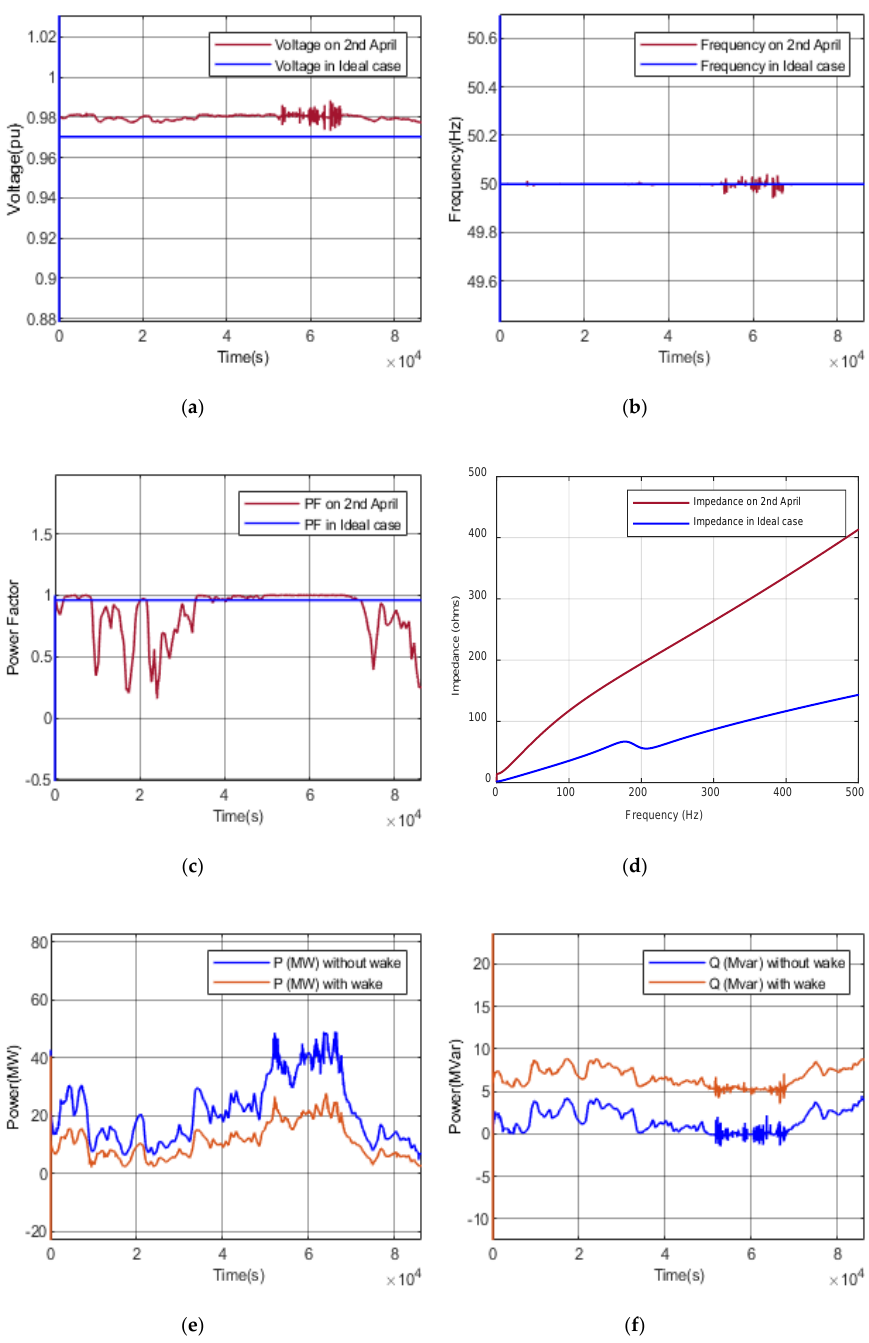
Figure 6. Case-1, Scenario 3: ( a ) Voltage (V) at PCC; ( b ) frequency (F) at PCC; ( c ) PF at PCC; ( d ) impedance (Z) vs. F; ( e ) P-trend; and ( f )